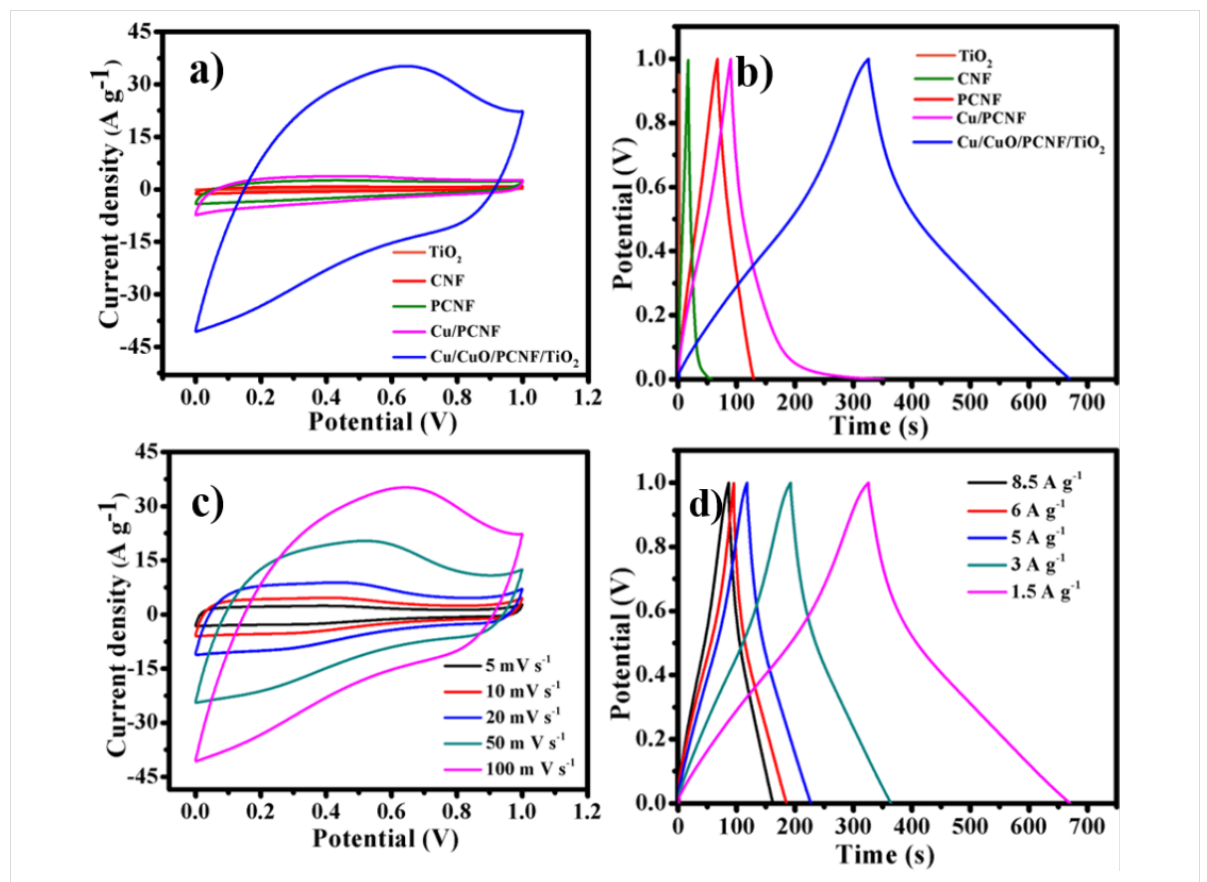
Figure 10: (a) Cyclic voltammetry (CV) curve, (b) galvanostatic charge–discharge (GCD) curve of TiO 2 , CNF, PCNF, Cu/PCNF and Cu/CuO/PCNF/ TiO 2 composites, respectively, (c) CV curves of Cu/CuO/PCNF/TiO 2 composites at different scan rates and (d) GCD curves of Cu/CuO/PCNF/TiO 2 composites at different current densities in a three-cell